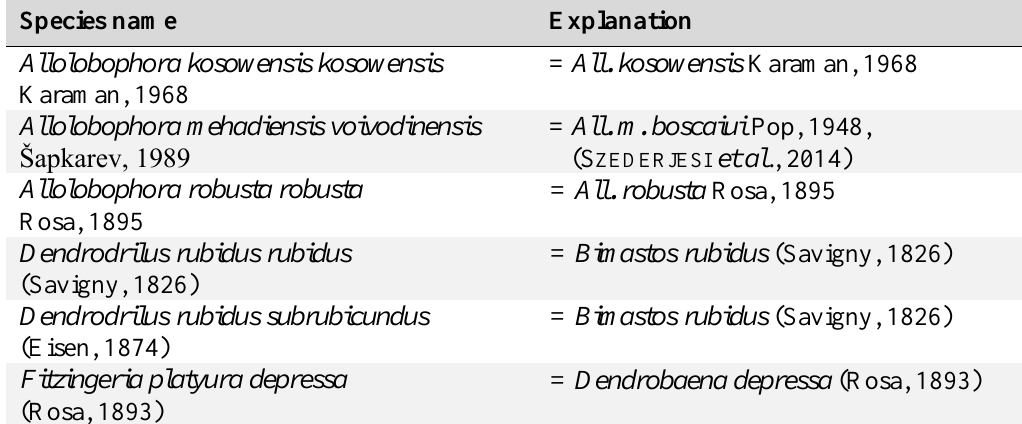
Table 2. Lumbricid taxa excluded from the checklist of Vojvodina